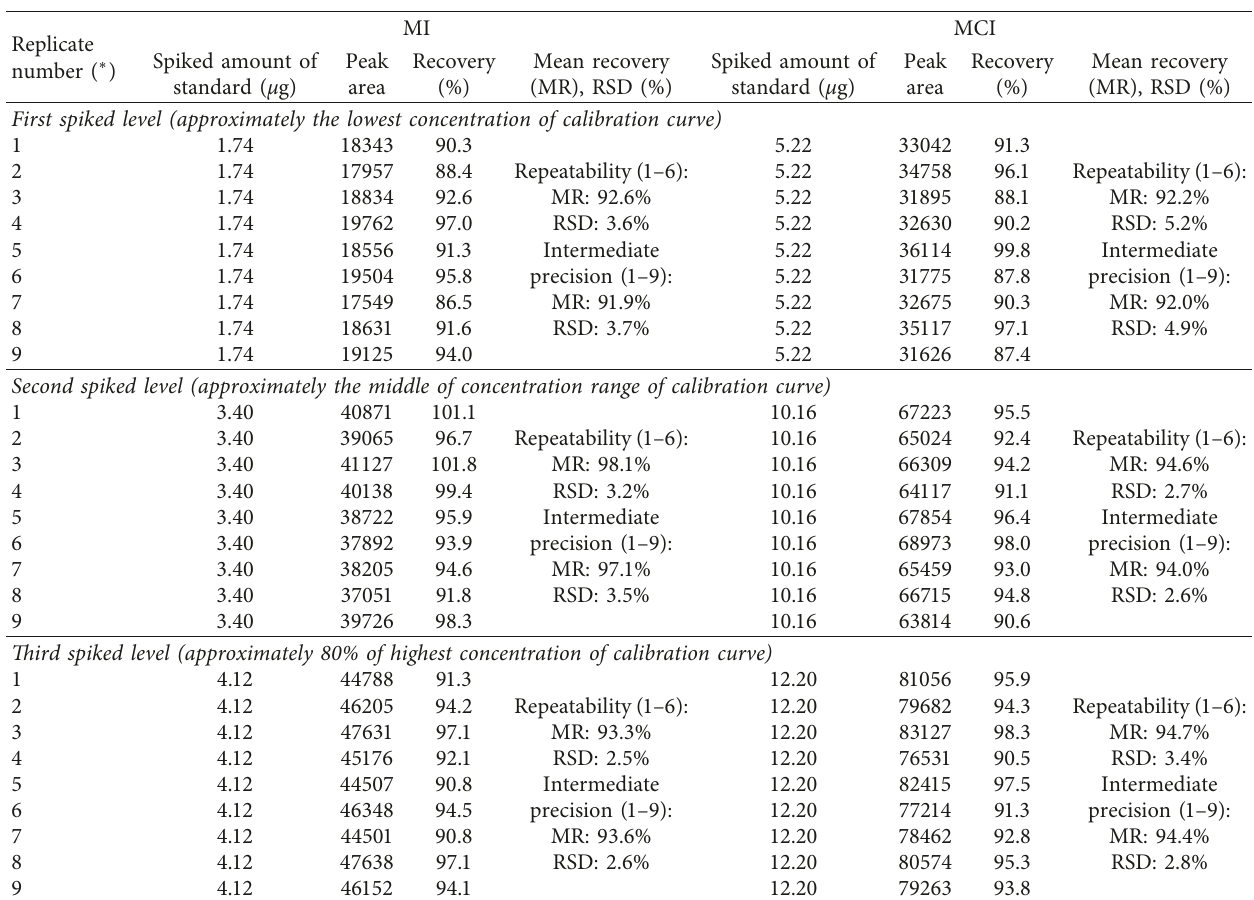
Table 4: Results of accuracy and